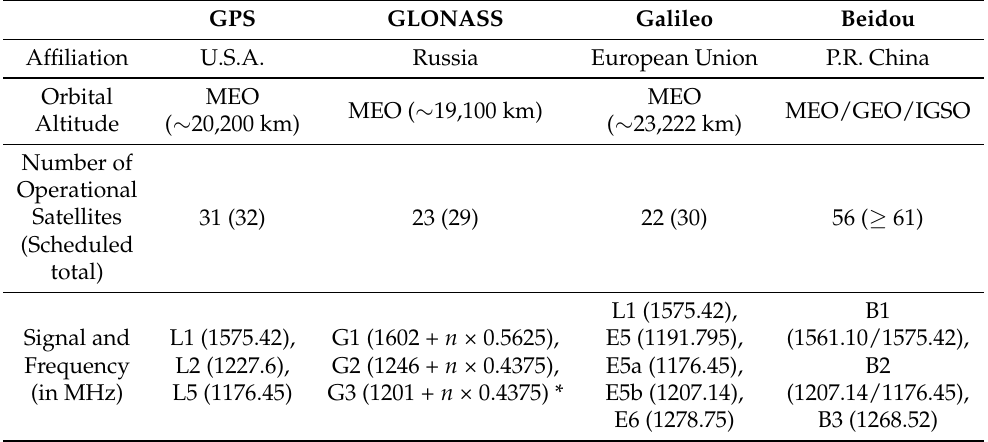
Table 1. Current status of GNSS constellations (* n stands for GLONASS frequency channel number).